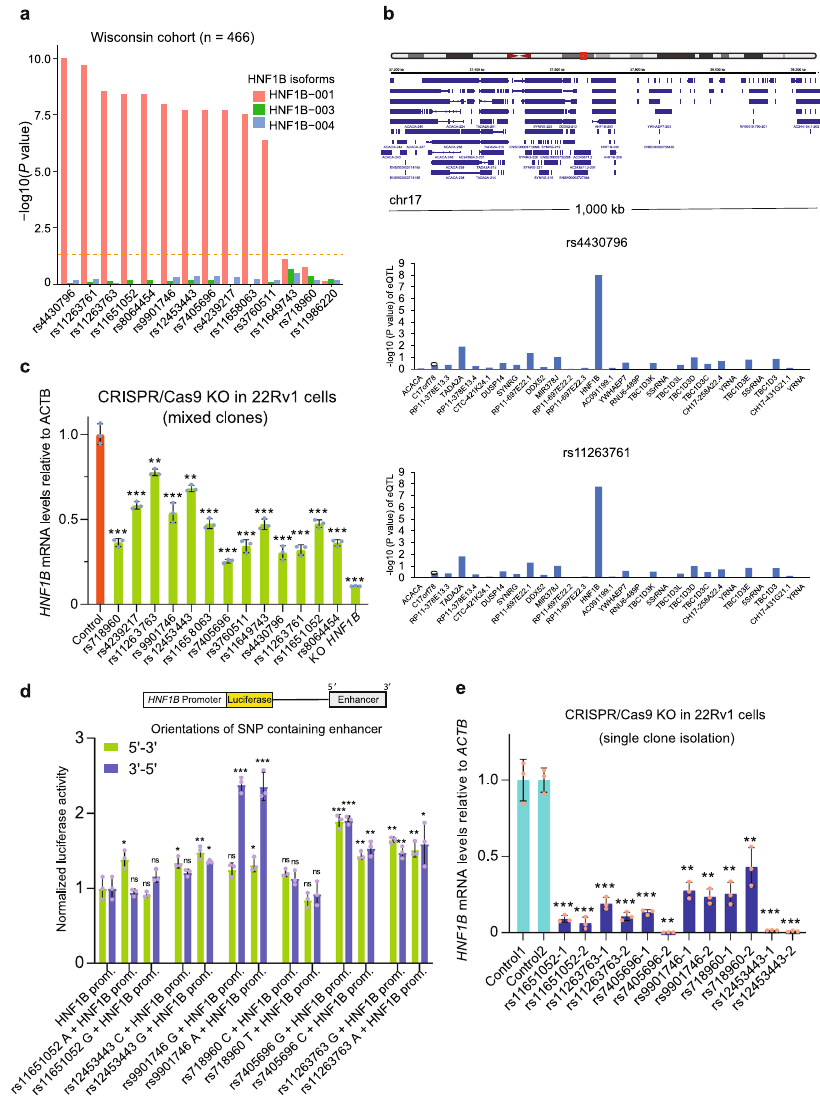
Fig. 2 | Multiple eQTL SNPs at 17q12 locus are potential causal variants and involved in the regulation of HNF1B expression. a Eleven of the thirteen SNPs in the HNF1B region were found to have signi fi cant eQTL association with HNF1B isoform 1 expressed in prostate glands ( n =466). The SNP rs11986220 within the 8q24 region was used as a non-relevant control site for the analysis. HNF1B-001 (NCBIsource:NM_000458);HNF1B-003(NCBIsource:NM_001165923);HNF1B-004 (NCBI source: NM_001304286). Genotype to gene expression correlations were assessed with linear regression. b The 17q12/HNF1B locus eQTL analysis of genes within 1-Mbp region using the Wisconsin cohort of benign prostate tissues ( n =466). c RT-qPCRanalysistodeterminethemRNAexpressionlevelsof HNF1B in 22Rv1 cells with partial knockout (KO) of each SNP region or dampened HNF1B